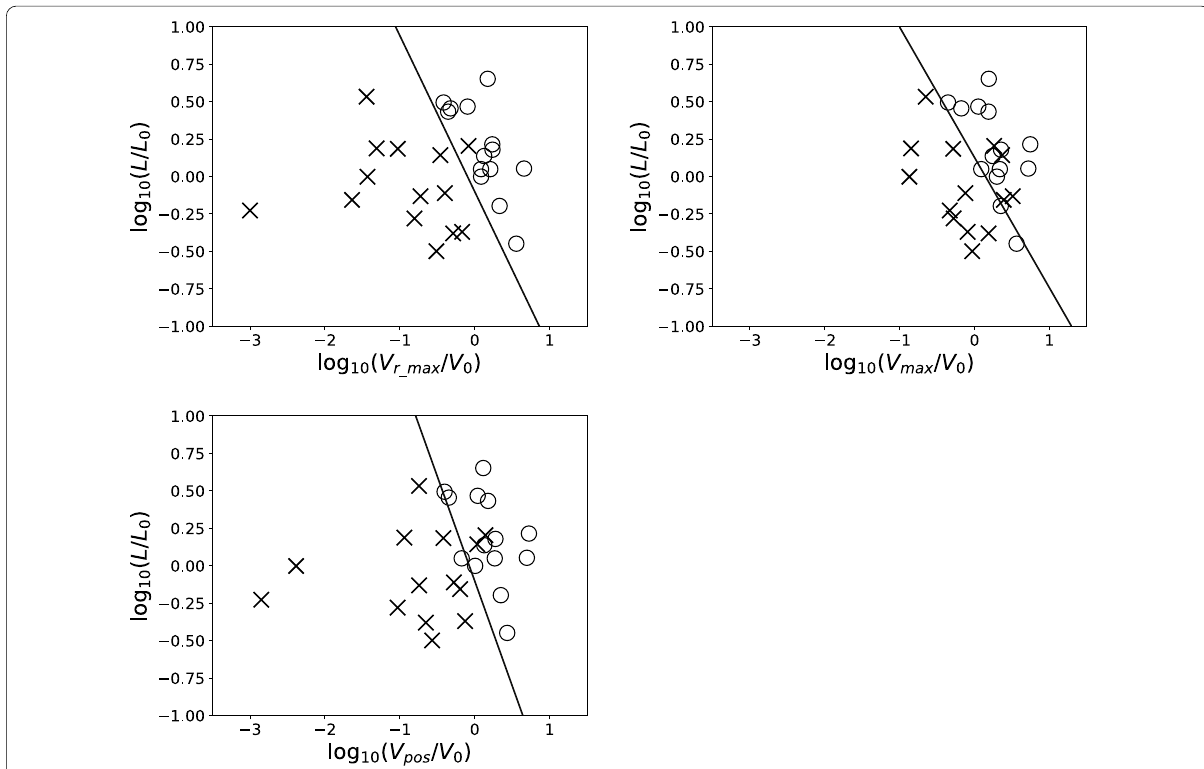
Fig. 1 Plots of filament eruptions according to V r_max (top left), V max (top right), or V pos (bottom left) and filament length, L , on a common logarithmic scale. V 0 and L 0 correspond to the typical velocity (100 km s − 1 ) and typical length (100 Mm) of filaments, respectively. Open circles and crosses represent events with and without CMEs, respectively. The solid lines are described in the